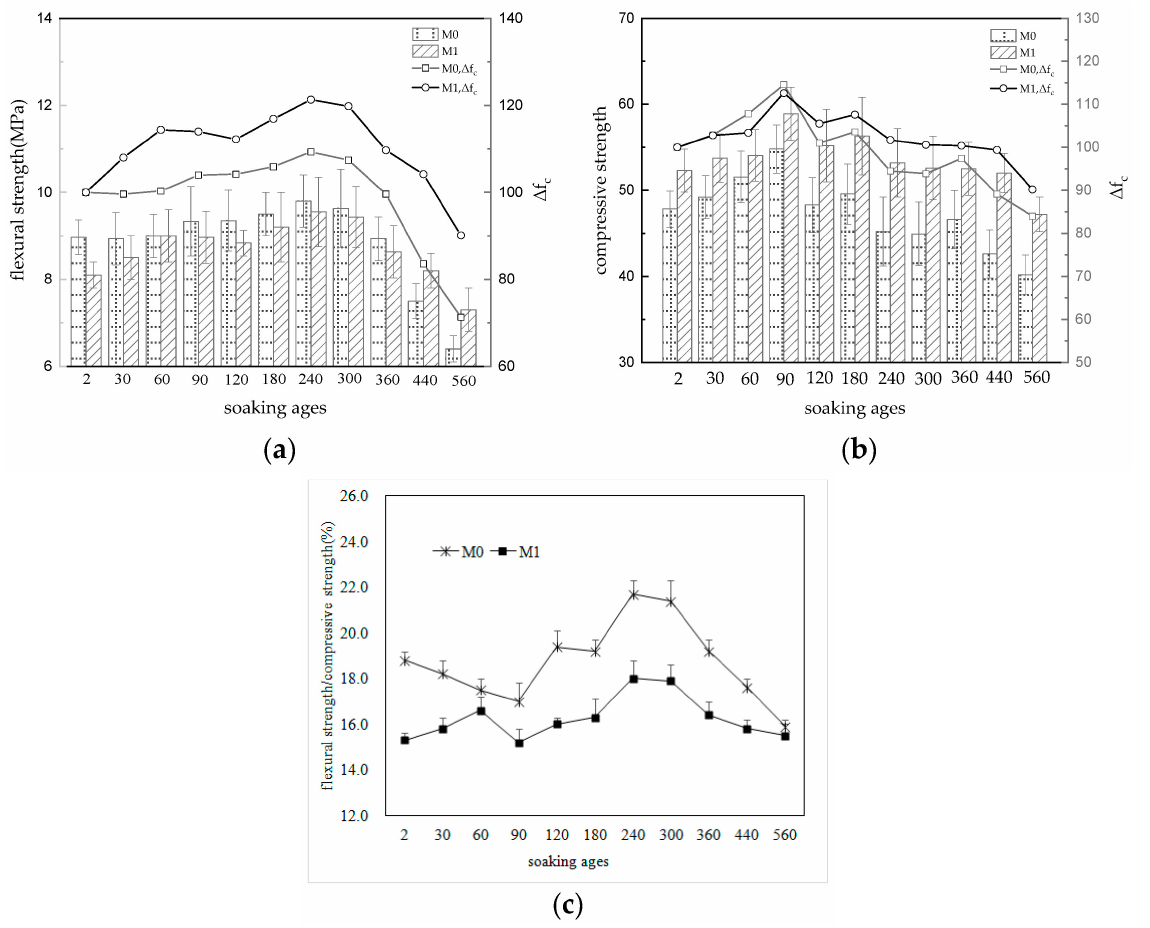
Figure 1. Strength development of MKPC specimens with different water immersion ages. ( a ) flexural strength ( b ) compressive strength ( c ) folding–compression